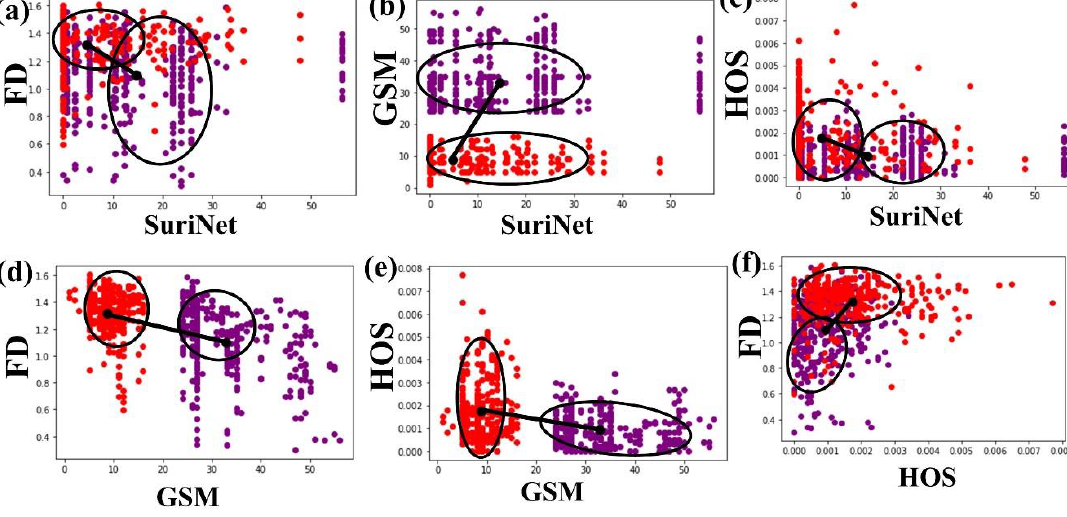
Figure 18. Correlation of AI (SuriNet) and the three biomarkers—FD, GSM, and HOS ( a ) FD vs. SuriNet, ( b ) GSM vs. SuriNet, ( c ) HOS vs. SuriNet, ( d ) FD vs. GSM, ( e ) HOS vs. GSM, and ( f ) FD vs. HOS.